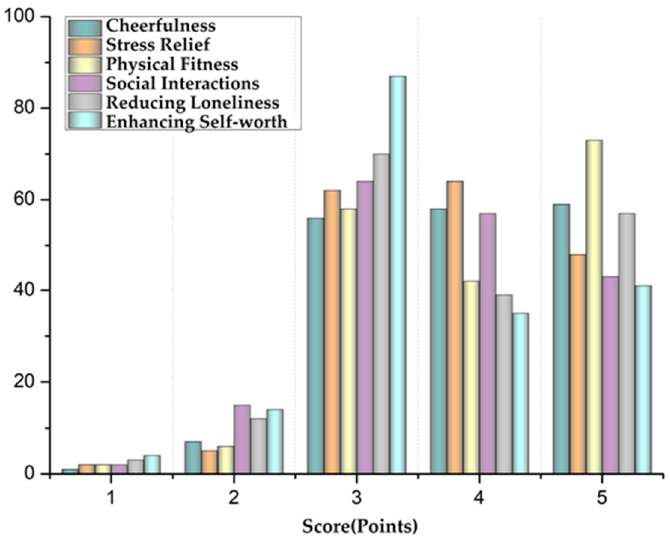
Figure 7. Self-reported post-activity restoration effects. Table 4. Activity restoration e ff